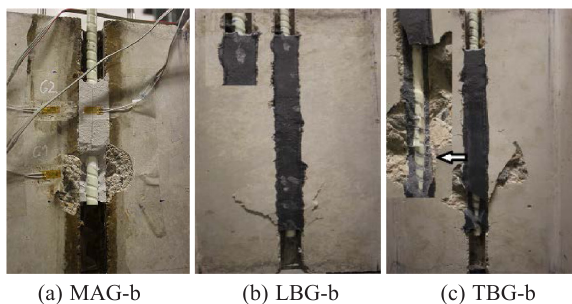
Fig. 7. Failure mode of specimens with GPRP bars